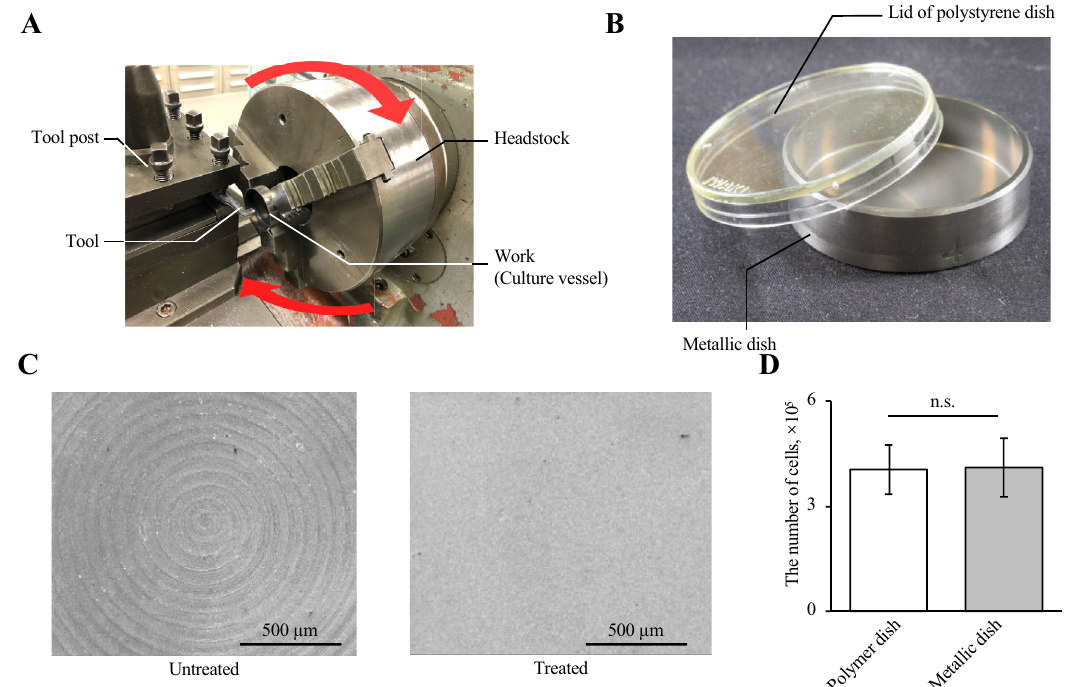
Figure 2. Fabrication and evaluation of the metallic cell culture vessel. Counterboring was performed on a stainless steel cylinder using a lathe for fabricating cell culture vessels ( A ). An overview of the metallic cell culture vessel ( B ). Images of cell culture surfaces with and without FPP ( C ). Comparison of the cell proliferation rate in a conventional polymer dish and the metallic vessel ( n = 4, mean ±